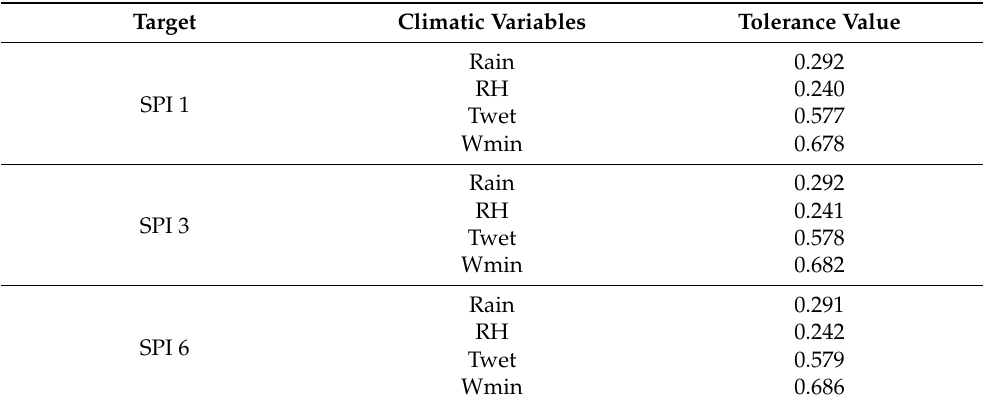
Table 3. Statistics of collinearity for the chosen best input variables.